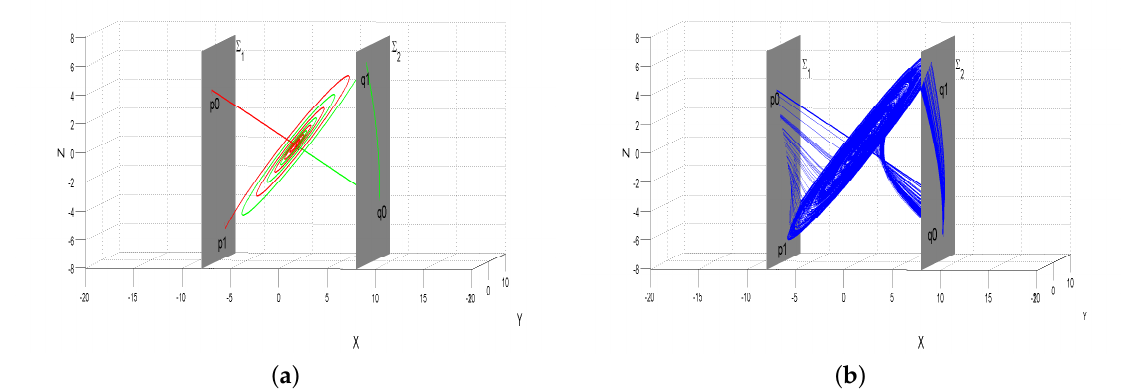
Figure 4. ( a ) The two homoclinic orbits of Example 4 e.g., adapted from Plew [15], with permission from American Society of Civil Engineers, 2011. are represented by red and green lines, respectively, which are both homoclinic to the saddle-focus equilibrium point p ; ( b ) A chaotic invariant set of Example 4 near the two homocliic